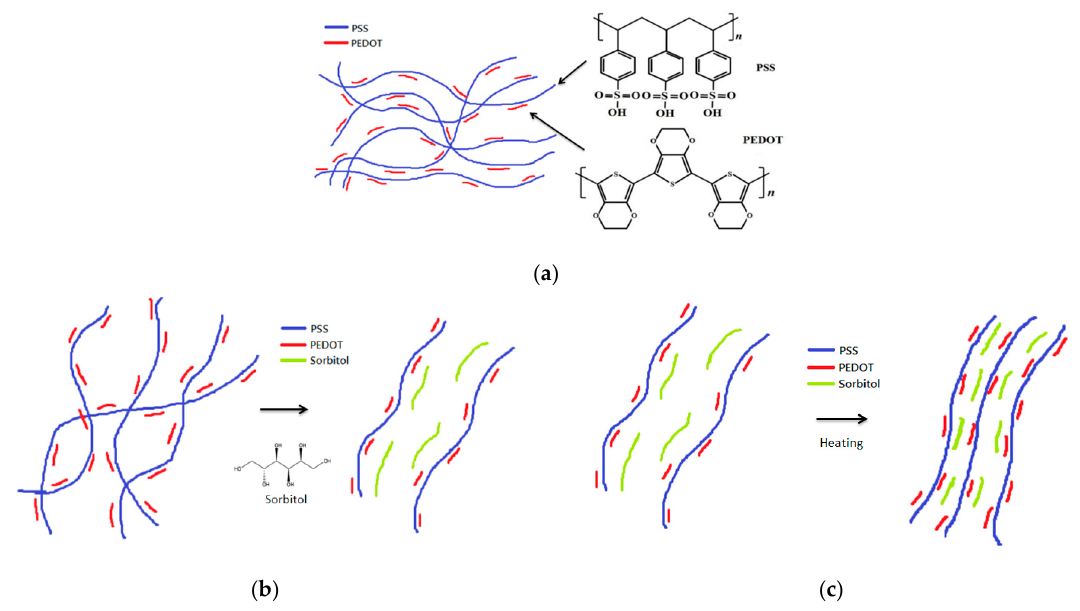
Figure 1. The investigation includes the ( a ) chemical structure of PEDOT:PSS; ( b ) the rearrangement of PEDOT:PSS with sorbitol; and ( c ) the schematic illustration of the heating of PEDOT:PSS with sorbitol.